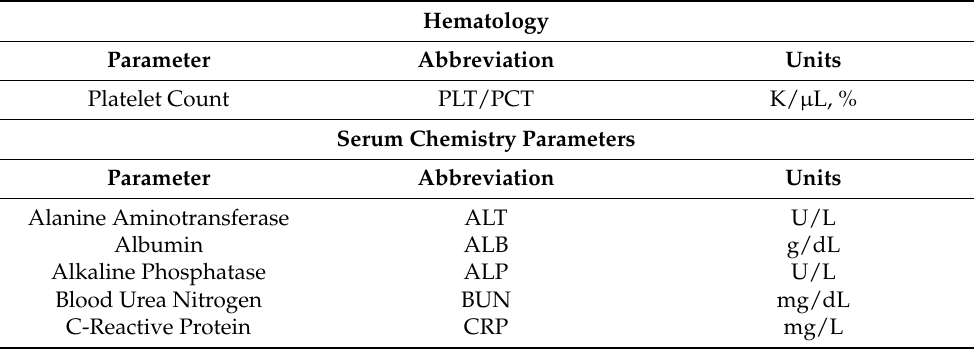
Table 1. Hematology and Serum Chemistry